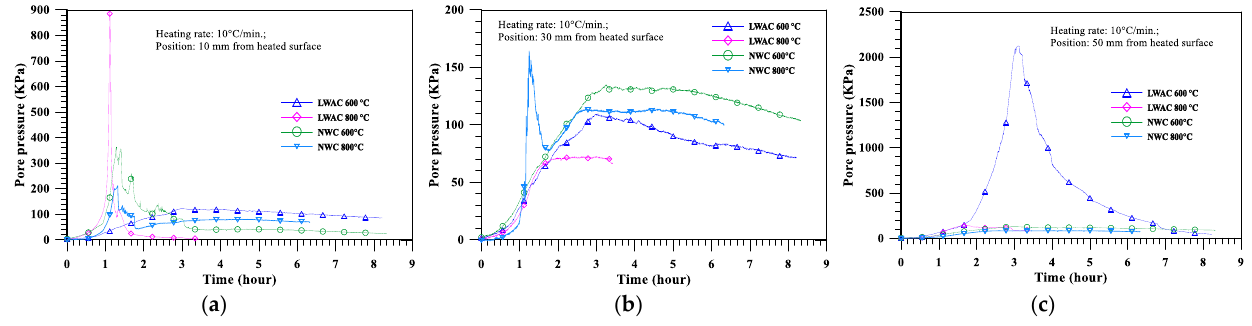
Figure 19. Effect of the target temperature on the pore pressure of air-dried specimens performed at a heating rate of 10 °C/min: ( a ) 10; ( b ) 30; ( c ) 50 mm from the heated surface.